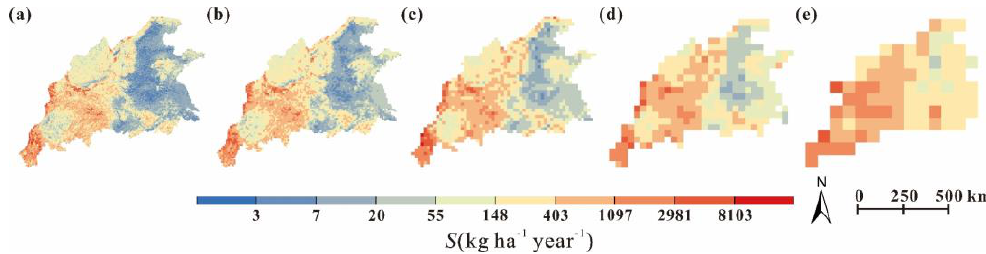
Figure 5. Spatial distribution of the scale effect index S : The spatial resolution is 10 km ( a ), 20 km ( b ), 40 km ( c ), 80 km ( d ), and 160 km ( e ).